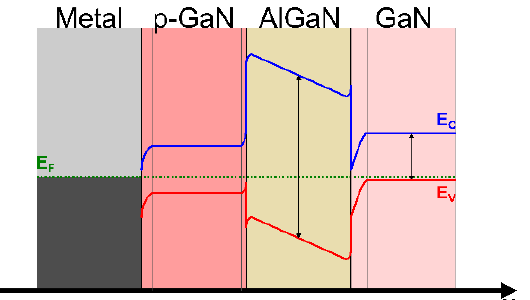
Figure 2. Ideal representation of a monodimensional band diagram of a metal/p-GaN/AlGaN/GaN heterostructure (not to scale) at thermodynamic equilibrium. The correct band bending depends on the exact charge spatial distribution.